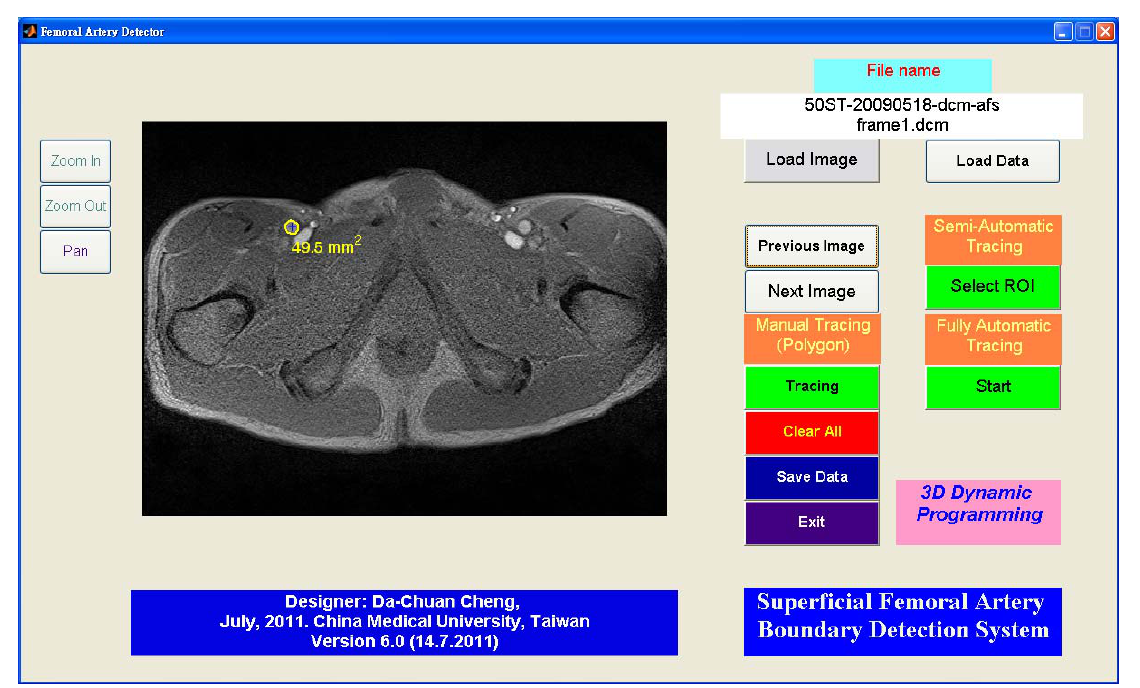
Figure 12. The software system GUI. The system can read DICOM and other image formats supported by MatLab. However, only the DICOM format offers pixel size